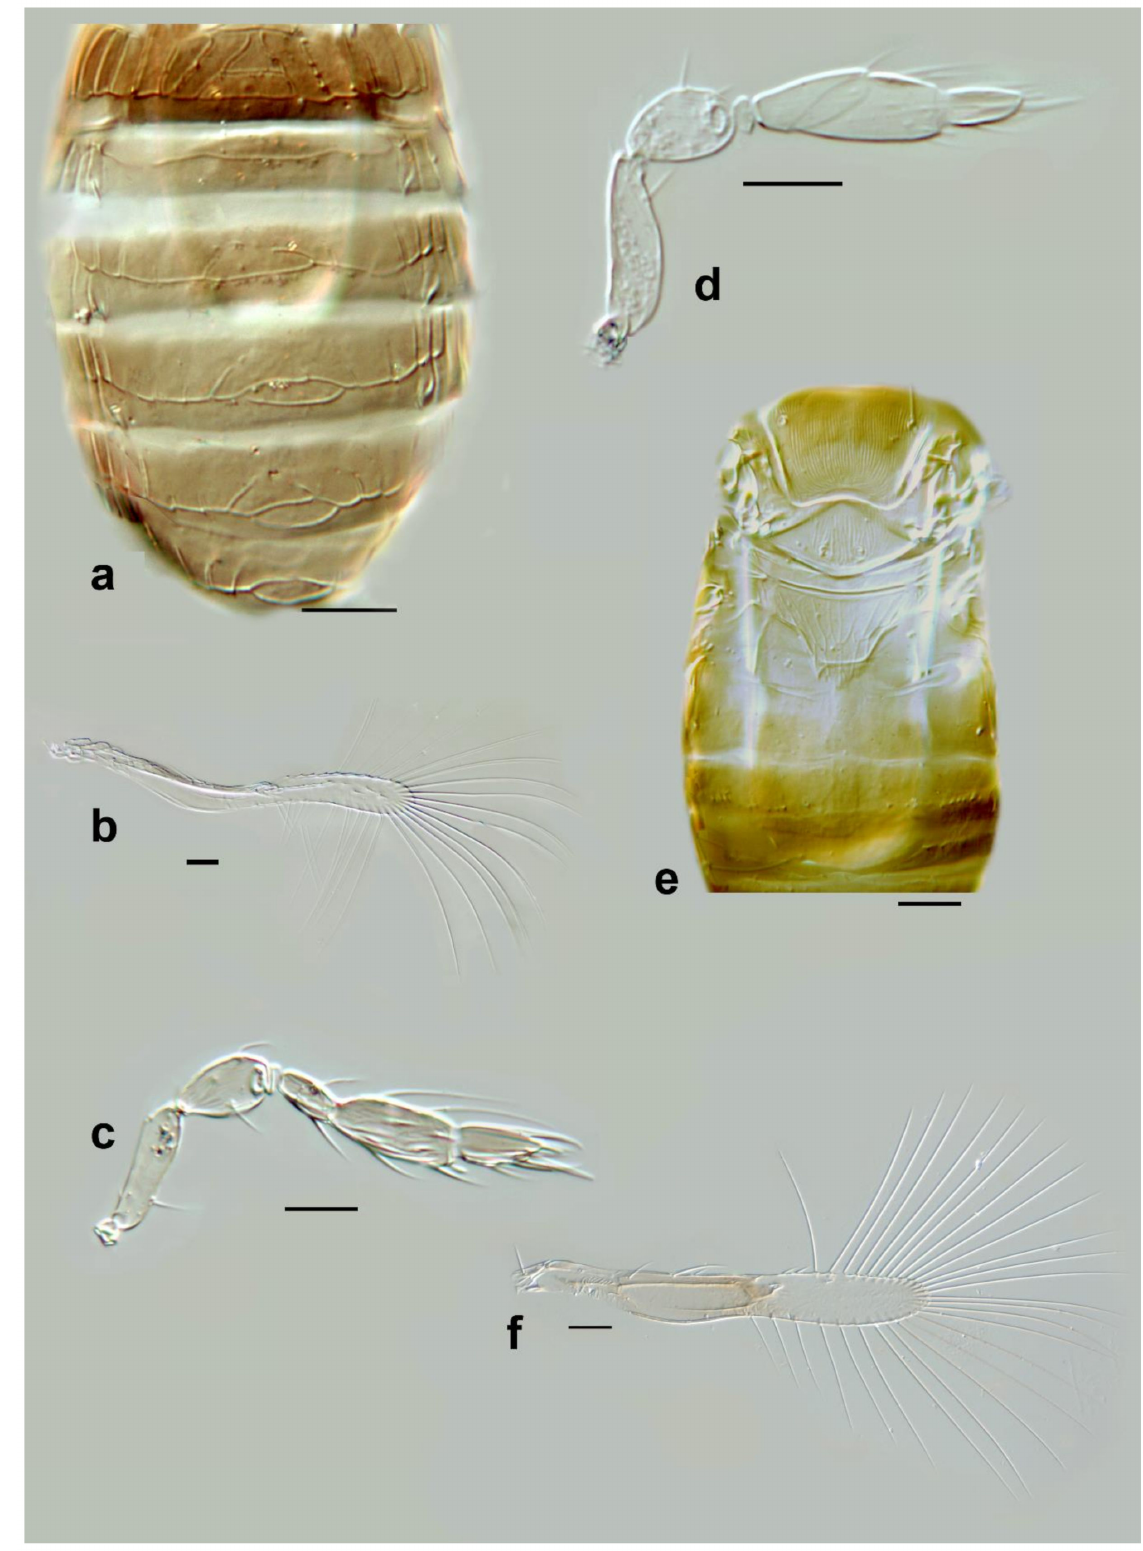
Figure 15. Photographs of Megaphragma species: ( a ) M. funiculatum , female metasoma (Holotype); ( b ) M. funiculatum , female fore wing (Holotype); ( c ) M. giraulti , female antenna (Holotype); ( d ) M. hansoni , female antenna (Holotype); ( e ) M. hansoni , female dorsal meso- and metasoma (Holotype); ( f ) M. hansoni , female fore wing (Holotype). Scale bars 20 µ